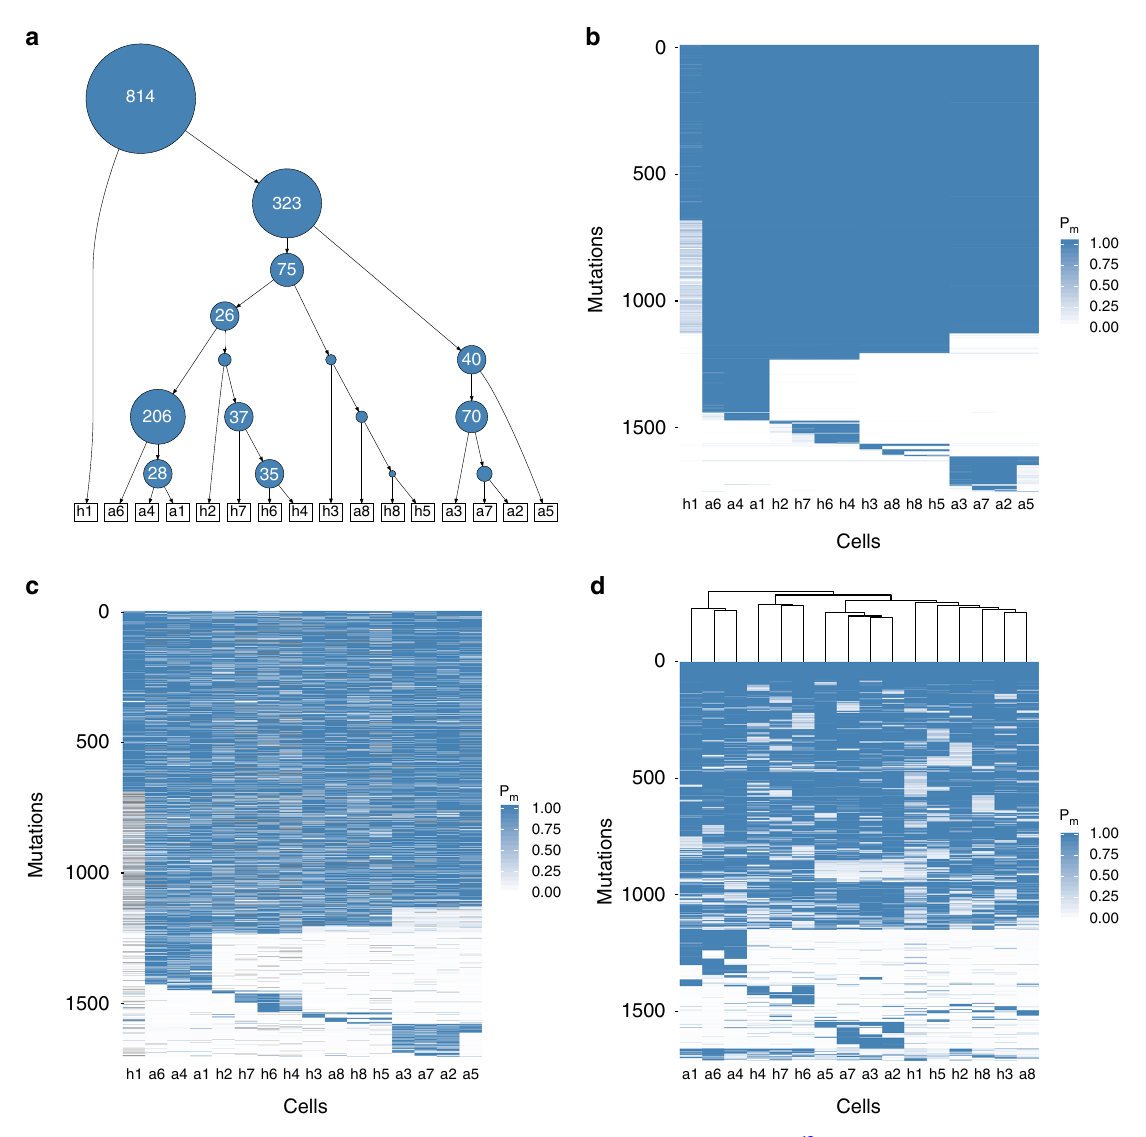
Fig. 4 Summary of the mutation calls obtained with Monovar and SCI Φ on a breast cancer patient dataset 13 consisting of 16 single tumor cells and a control normal bulk sequencing dataset. a Cell lineage tree with average number of mutations per inner node as identi fi ed by SCI Φ . The area of a node is proportional to its number of assigned mutations. b Posterior probability of SCI Φ mutation calls clustered according to the tree in a . c Probability of Monovar mutation calls for loci identi fi ed as mutated by SCI Φ and clustered according to the tree in a . d Probability of Monovar mutation calls for loci identi fi ed as mutated by SCI Φ and clustered